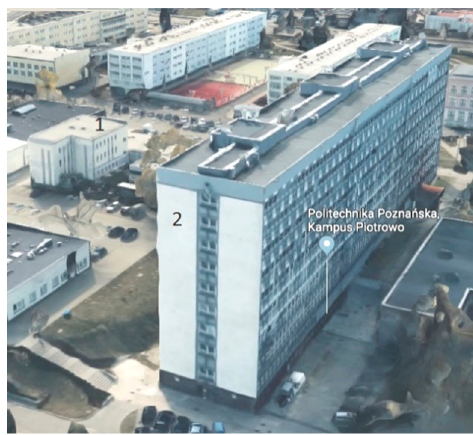
Figure 1. External view of the SKNX and EIEE Laboratory building ( 1 ) and the educational building